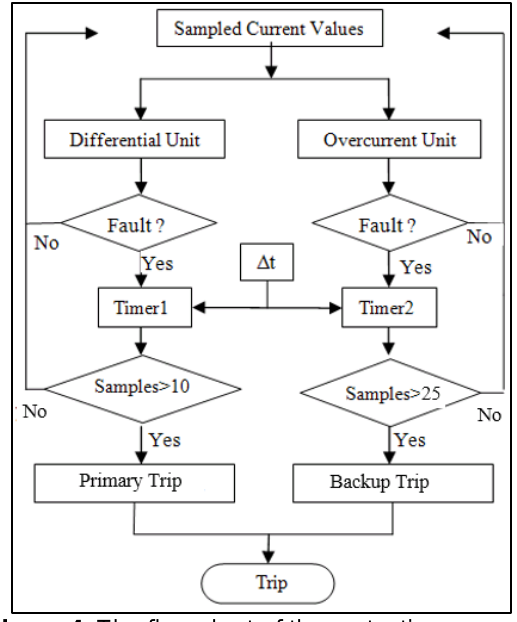
Figure 4. The flow chart of the protection program